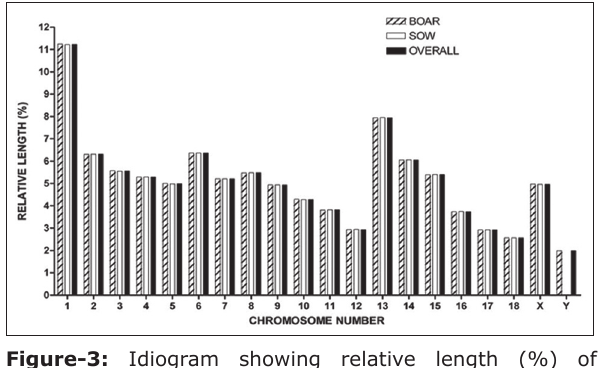
Figure-3: Idiogram showing relative length (%) of chromosomes of indigenous